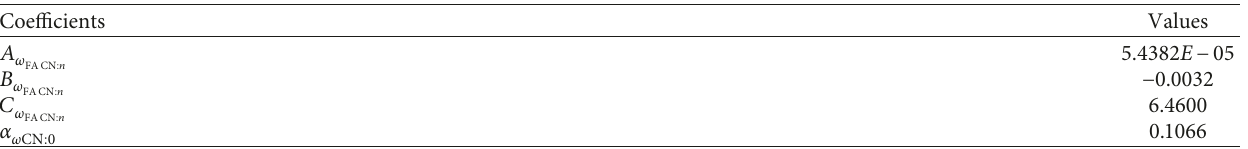
Table 24: Coefficients for the estimation of the acentric factor (valid from C8 :0 to C22 :0) according to equation (48). Coefficients